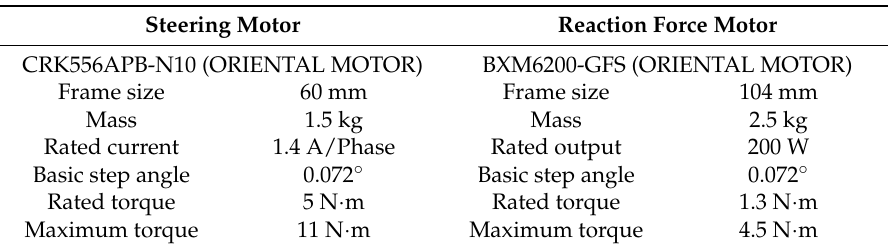
Table 1. Steering motor and reaction force motor